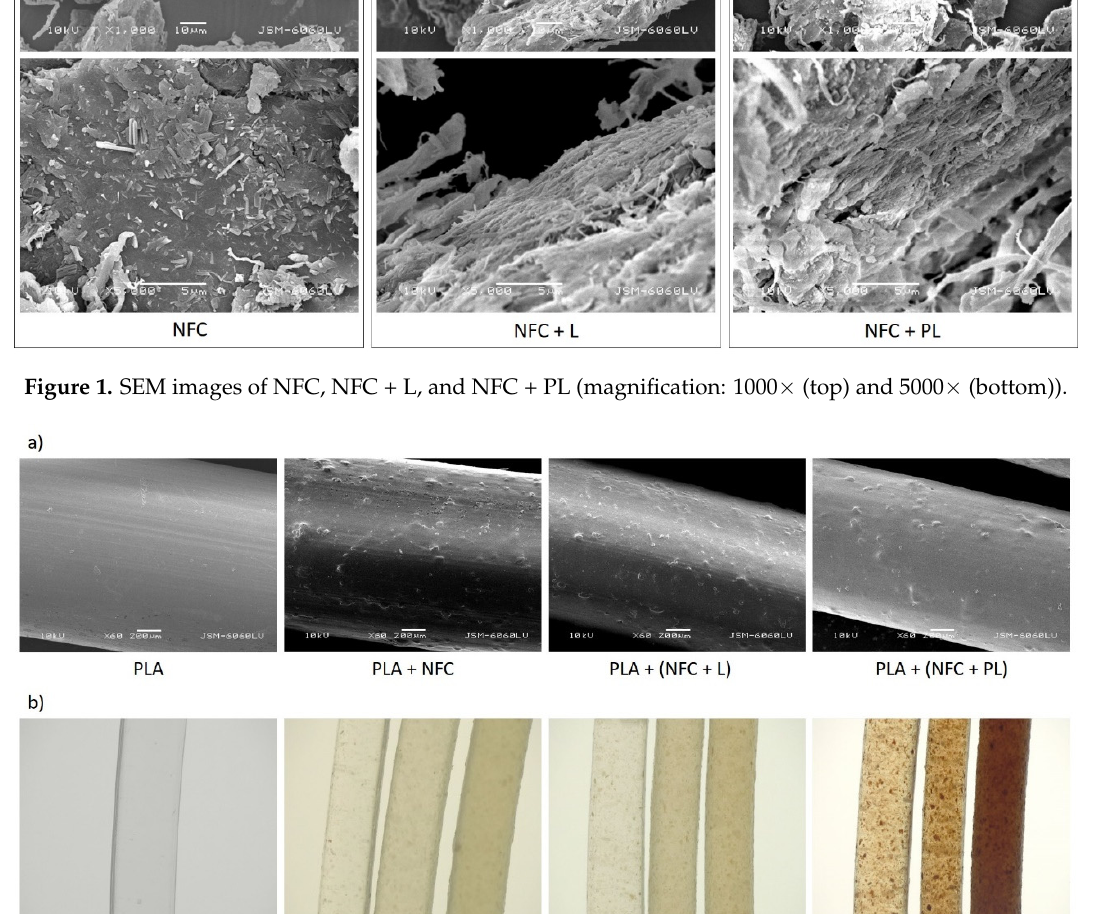
Figure 1. SEM images of NFC, NFC + L, and NFC + PL (magnification: 1000× (top) and 5000× (bottom)).